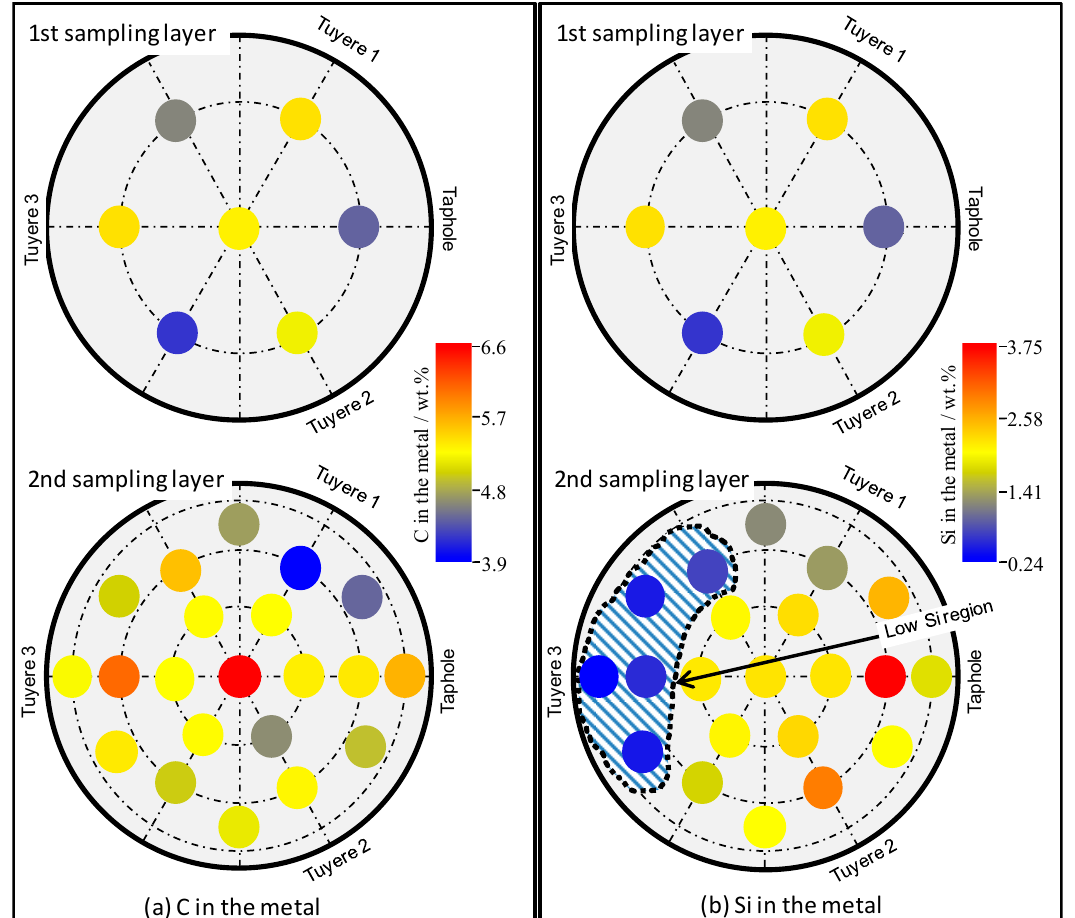
Figure 7. Distribution of C and Si in the metal samples from the EBF hearth: (a) C in the metal; (b) Si in the metal.